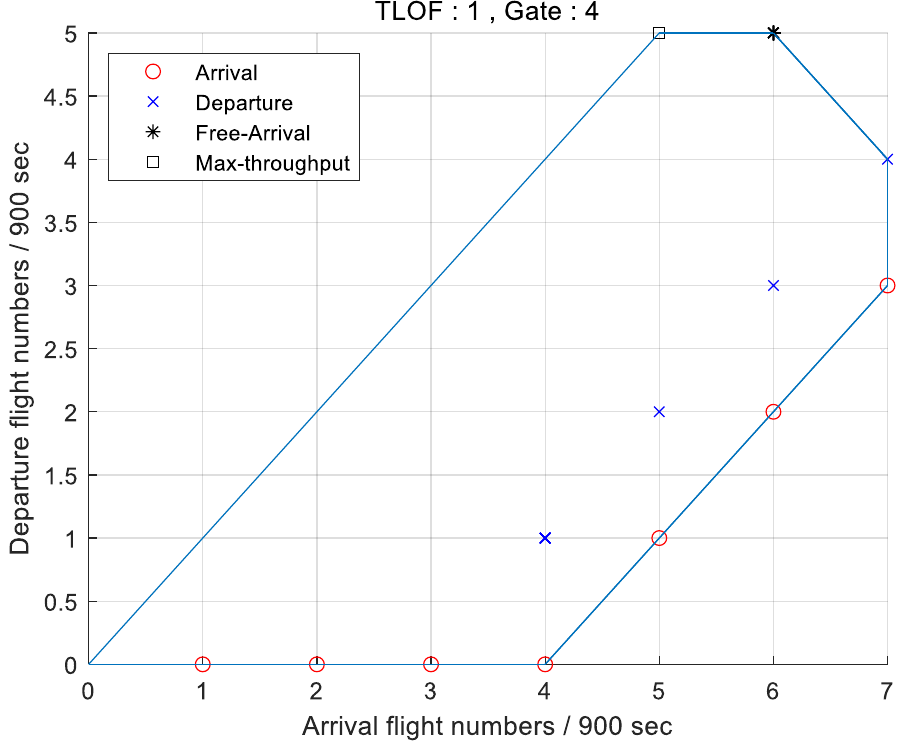
Figure 26. Example of vertiport capacity (one TLOF pad, four gates).